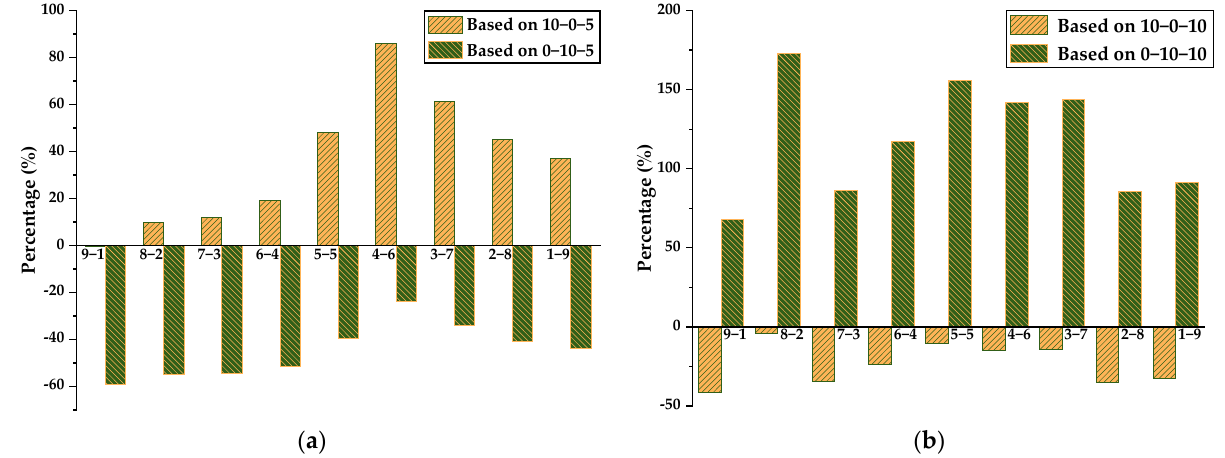
Figure 8. Chemical shrinkage of ternary systems and comparison: ( a ) with 5% CS; ( b ) with 10% CS.